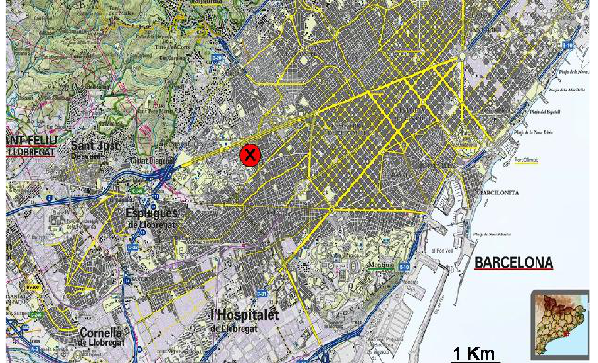
Figure 2(a) . Average DMPS size distributions (dN/dlog(D) - cm -3 ) for different seasons for3